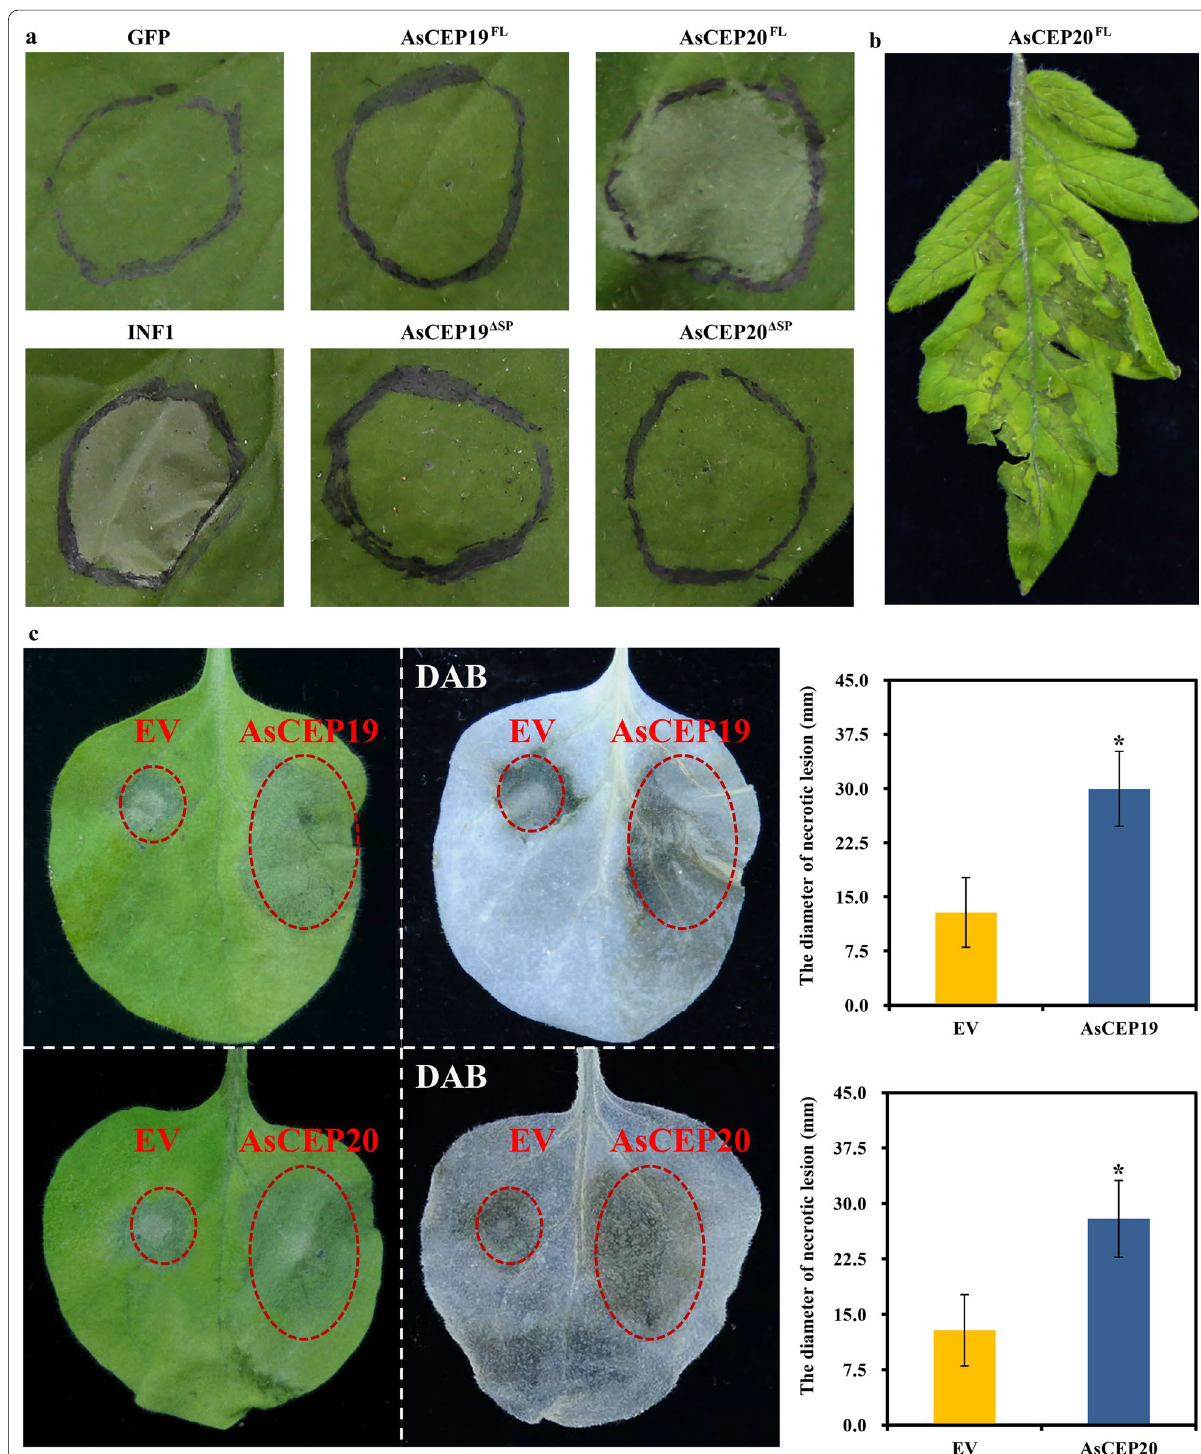
Fig. 6 Transient expression of AsCEP19 and AsCEP20 in N. benthamiana and tomato leaves. a The full-length (FL) AsCEP20 (AsCEP20 FL ) triggered obvious necrotic lesion at seven days post-infiltration. The GFP and INF1 plasmid constructs were infiltrated as negative and necrosis control, respectively. b AsCEP20 FL elicited plant cell death in tomato leaves. c AsCEP19 FL and AsCEP20 FL promoted P. infestans infection in N. benthamiana . AsCEP19 FL , AsCEP20 FL , and GFP (empty vector) were individually agroinfiltrated into leaves for 48 h, and then the infiltrated leaves were detached from plants and inoculated with 10 μL zoospore suspension (5 10 4 zoospores/mL) of P. infestans . At 5 days post-inoculation (dpi), lesion size was × measured, and the leaves were stained with DAB (Two-tailed Student’s t test, * P < 0.05, SD, n ± =